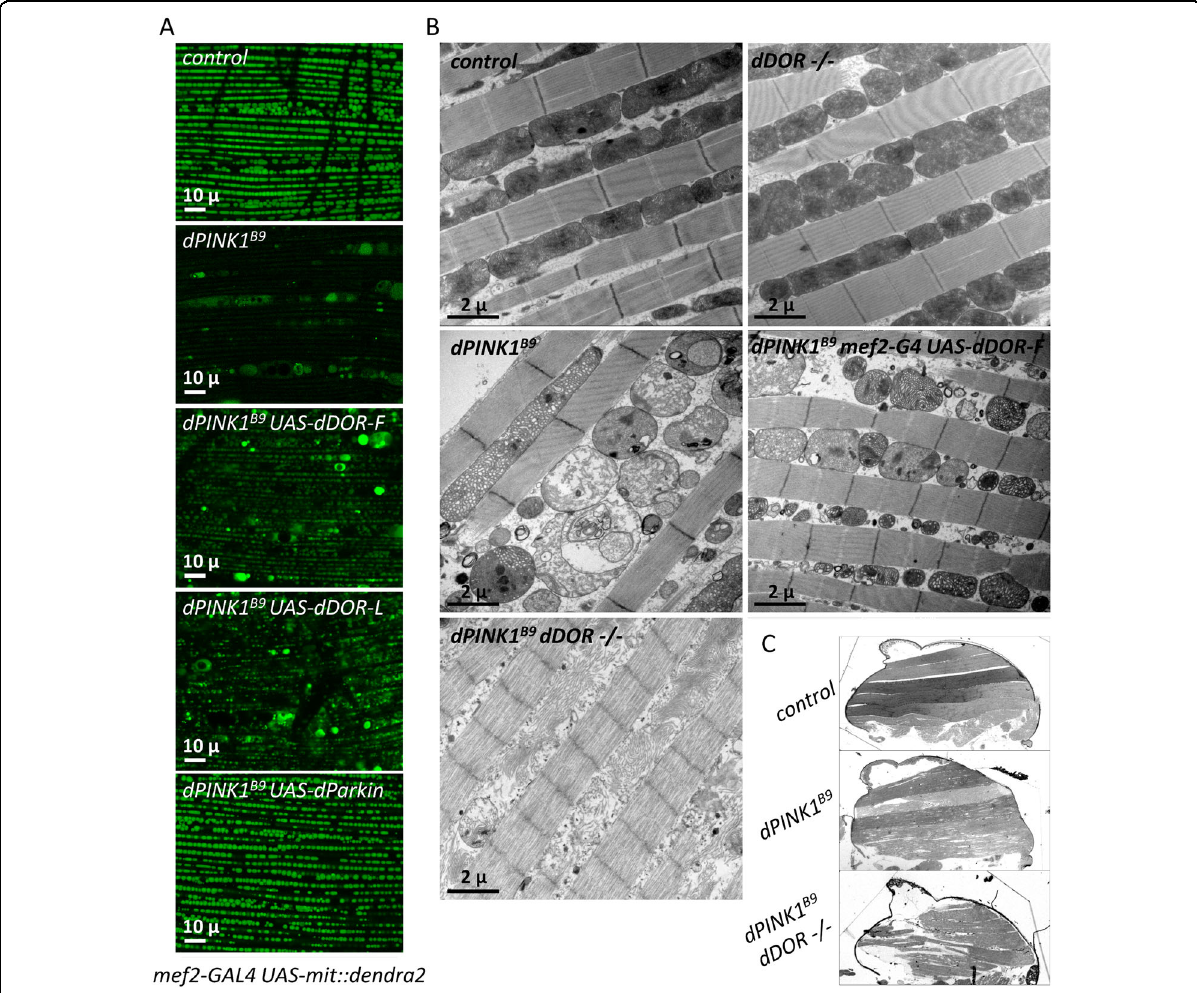
mef2-GAL4 UAS-mit::dendra2 (staining of the mitochondrial matrix) adult male dorsal longitudinal fl ight muscles (DLM) from control, dPINK1 B9 hemizygous mutant or dPINK1 B9 hemizygous mutant expressing UAS-dDOR transgenes ( dDOR-F but not dDOR-L contains EcR binding motif). B Transmission electron microscopy images of adult fl y thorax sections showing mitochondrial ultrastructure in DLM muscle of control, homozygous dDOR null mutant, dPINK1 B9 hemizygous mutant, dPINK1 B9 hemizygous mutant expressing UAS-dDOR-F and dPINK1 B9 hemizygous mutant combined with homozygous dDOR null mutation. C Fly thorax sections of control, dPINK1 hemizygous mutant and dPINK1 hemizygous mutant combined with dDOR homozygous mutation stained with Toluidine blue showing DLM muscles. In dPINK1 hemizygous mutant, DLM muscles contain intact fi bers that span longitudinally, as seen in the control fl y. In dPINK1 hemizygous mutant combined with dDOR homozygous mutation, the extremities of DLM muscle appear ripped off from the cuticle and the muscle fi bers are disorganized and torn. Four thoraces were analyzed for each